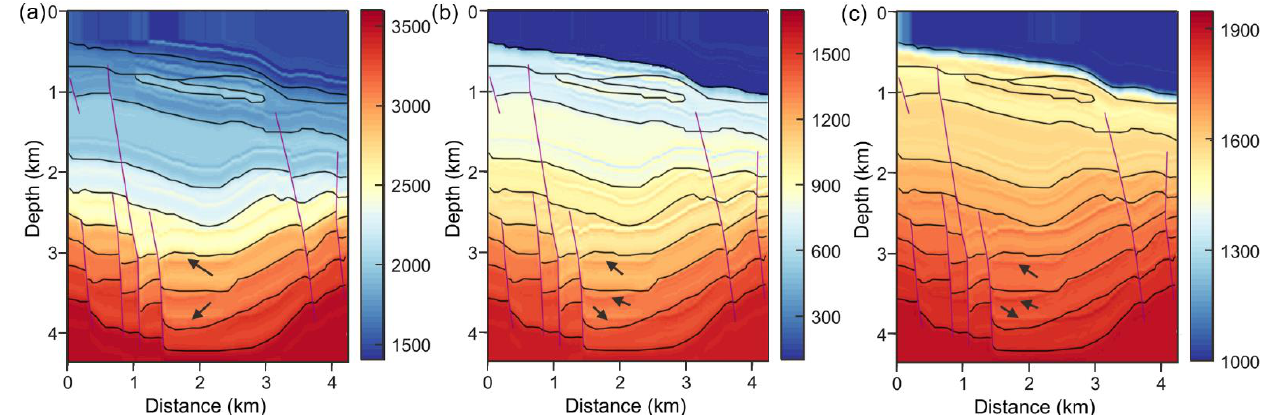
Figure 7. The inverted models from the noise-free data using the conventional AVO method: ( a ) P-wave velocity, ( b ) S-wave velocity, and ( c ) density. The black lines indicate the stratigraphic horizons and the red lines indicate the faults. The inverted stratigraphic horizons indicated by the black arrows do not agree well with the real ones.